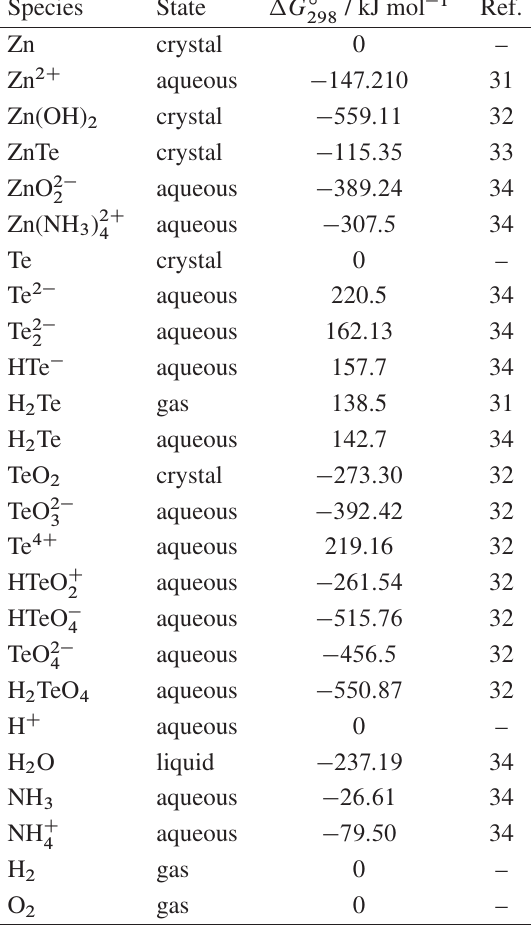
Table 1. Thermochemical data considered for the calcu- lation of potential-pH diagram of the Zn-Te-NH 3 -H 2 O